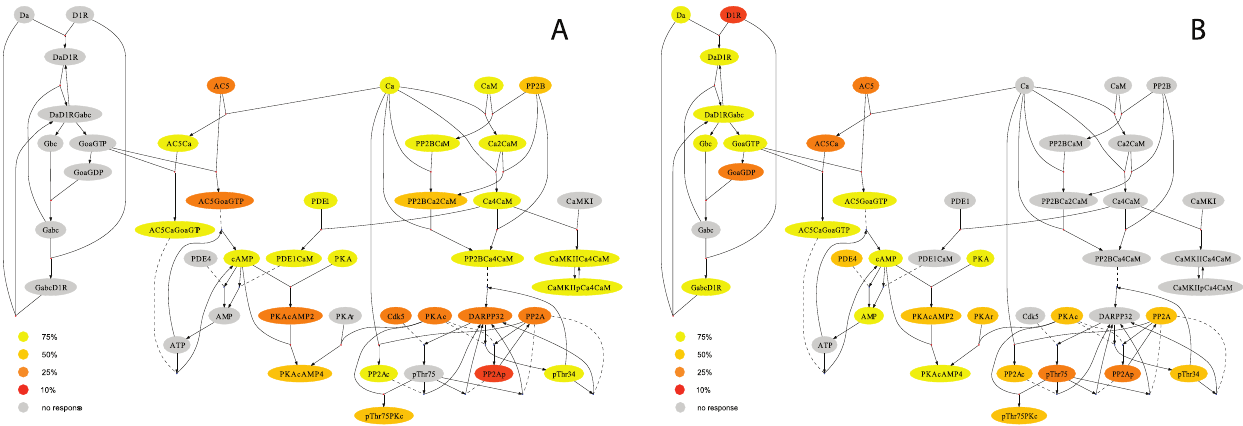
Figure 8. Modularity in signal transmission. Species nodes are colored according to their saturation/depletion status (EC90/EC10) in response to percentage of input. A. Input is Ca (100 nM…10 m M ), Da is set at 5 m M . The figure shows a large number of species which have no response (less than 10%) to Ca input, two separate pathways are apparent. Species inactivate at low input levels in the ‘integration zone’. B. Input is Da (20 nM…5 m M ), Ca is set at 8 m M . The graph shows input-dependent inactivation of links. Individual effects can be studied. For instance, PDE4 (in contrast to PDE1, PDE1CaM) shows responsivity to Da input because of a larger complex formation with cAMP, which subtracts from the enzyme